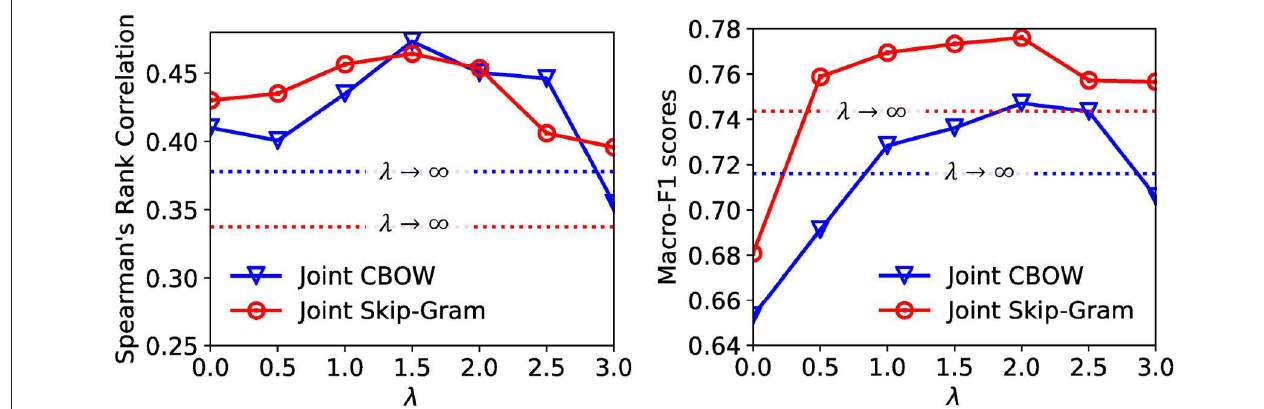
FIGURE 3 | Hyperparameter study on word similarity (left) and text classification (right) .